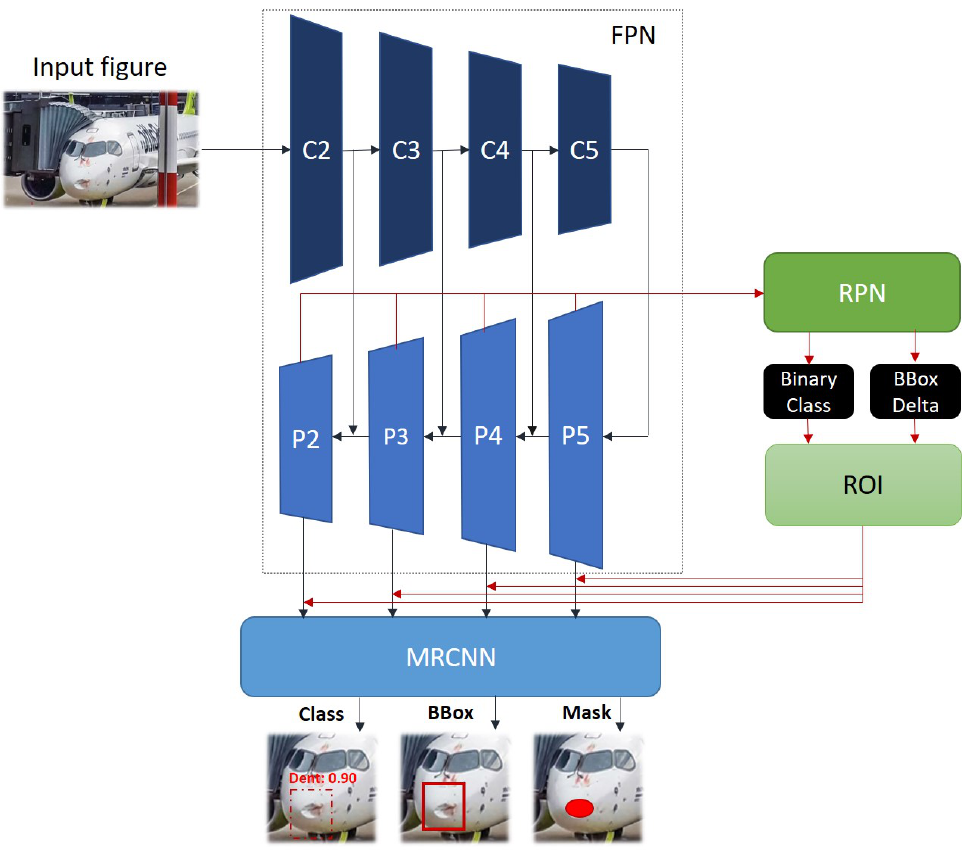
Figure 1. MASK R-CNN architecture and its underlying functionality blocks